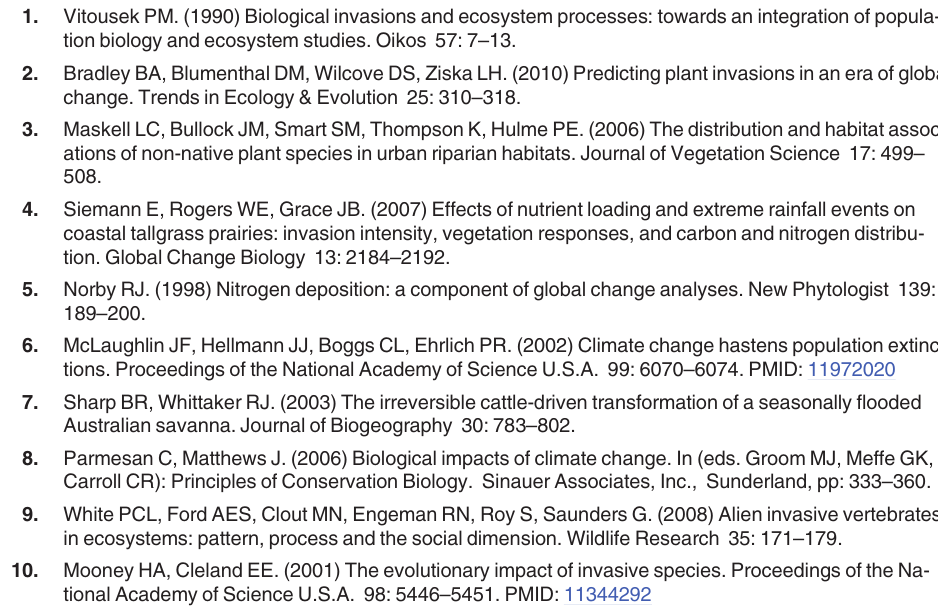
S1 Table. NMDS scores and correlations of measured environmental variables and ordina- tion axes. S2 Table. Scatterplot of relationships among measured environmental